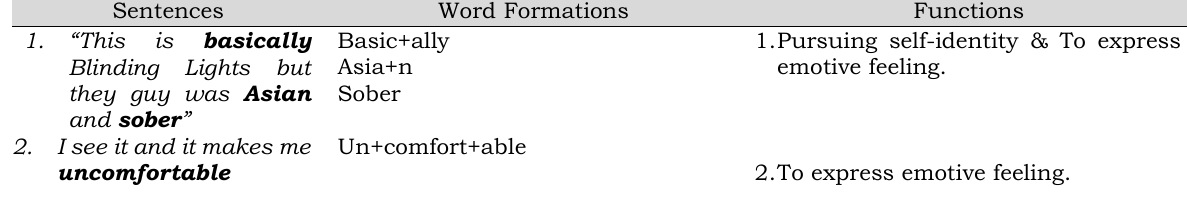
Table 3. Derivation and multiple process word formation